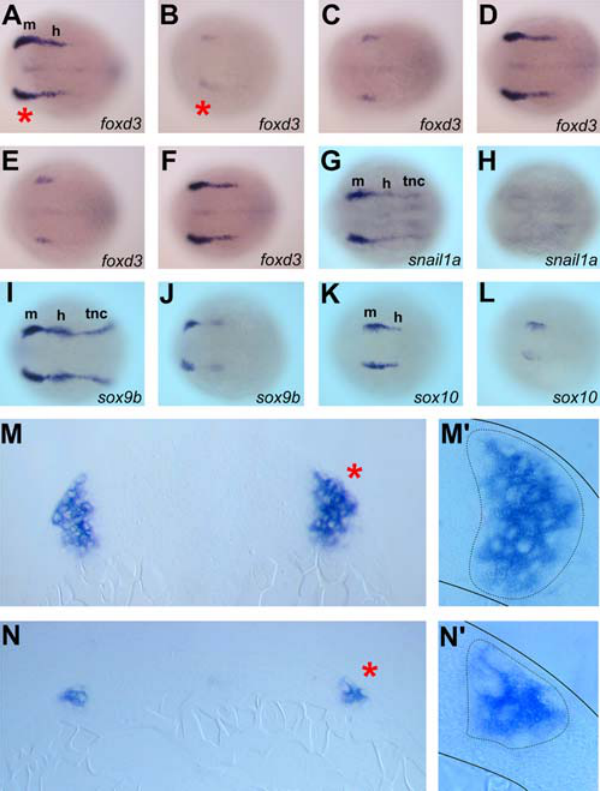
Figure 6. mych MO impairs early neural crest induction . A–F. Dorsal view of foxd3 expression at 4-somite stage embryos. Embryos injected with 4ng of mych UTR MO (B), 5ng of mych SP MO (C), or 2ng of mych UTR MO (B) plus 2.5ng of mych SP MO (C) showed reduced foxd3 expression. This phenotype was rescued by mych mRNA coinjection (D,F). G–L. Dorsal view of control MO-injected (G,I,K) and mych UTR MO injected embryos (H,J,L) hybridized to snail1a (G,H), sox9b (I,J), and sox10 (K,L). M–N. Sections of the foxd3 expression region of cont MO (M,M’) and mych UTR MO (N,N’) injected embryos. Red asterisks in A and B indicate the location of transverse sections, and asterisks in M and N indicate the regions magnified in M’, N’. h; hindbrain neural crest, m; midbrain neural crest, tnc; trunk neural crest.